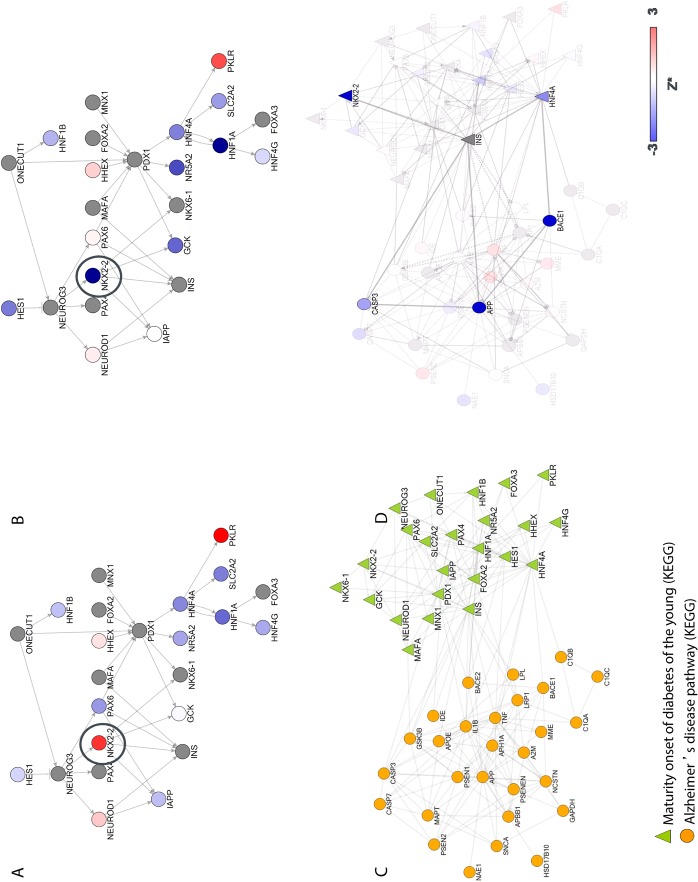
“Maturity onset diabetes of the young” pathway (KEGG) [26].This pathway was found to be a significant regulator of sAPPβ. Proteins/genes are coloured based on their corresponding Z* values for sAPPα (A), and sAPPβ (B). Genes do not behave equally across the different readouts. For example, knock-down of NKX2–2 (black circle), which is a homeobox transcription factor, results in a significant decrease of sAPPβ (Z* = –12.3) but increases sAPPα (Z* = 2.4). Hence, the mechanism by which this pathway would favour the production of sAPPβ over sAPPα could potentially be mediated by this transcription factor. C. “Maturity onset diabetes of the young (MODY) (KEGG)” and "Alzheimer's disease" pathways (KEGG database). The network illustrates how proteins from these two pathways interact with/regulate each other. D. Two potential mechanisms by which sAPPβ levels can be lowered. One hypothetical mechanism could be via NKX2–2 regulation of APP processing via an insulin-mediated pathway. Knock-down of NKX2–2 would result in increased insulin levels leading to inhibition of caspase 3 activation and hence decreased cleavage of APP by caspase 3 at the BACE1 cleavage site[69–71]. Increased insulin levels have been associated with decreases of intracellular accumulation of Aβ levels, and caspase 3 has been shown to regulate APP processing via BACE1-related mechanisms [71–73]. Knock-down of caspase 3 in this study reduces sAPPβ levels. Although the insulin gene was not included in the screen, the knock-downs of NKX-2 and caspase 3 are consistent with known biology (i.e. reduction in levels of sAPPβ. An alternative hypothesis could be via HNF4A, a transcription factor previously characterized as binding to the BACE promoter [74]. Genes/proteins in the network are coloured by their corresponding sAPPβ Z* values.